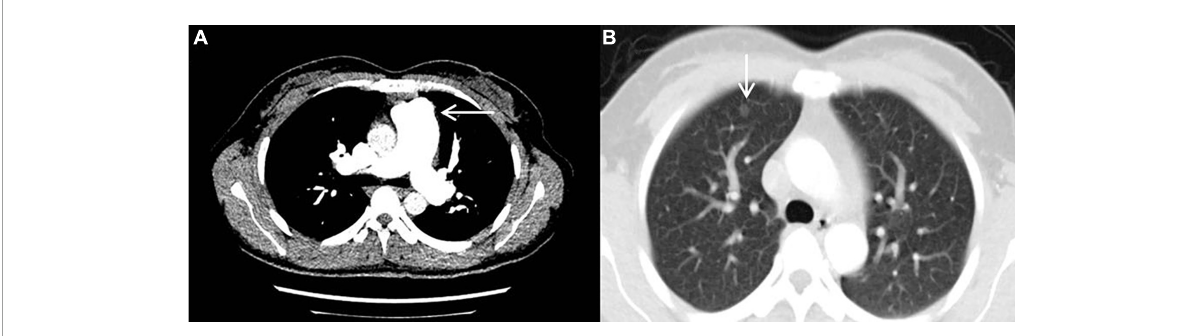
FIGURE2 Computed tomography pulmonary angiography. (A) No obvious filling defect or vascular malformations were observed. (B) The ground-glass opacity that was 7.8 mm × 7.5 mm in diameter and located in the right upper lung lobes was